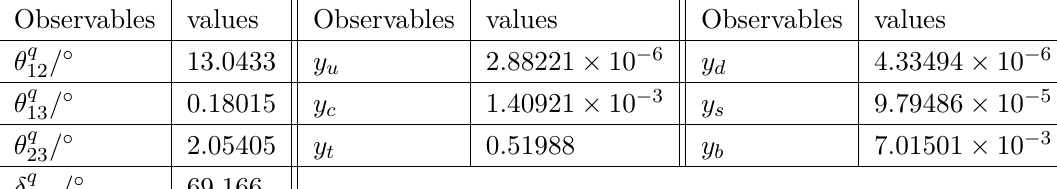
Table 5 . The predictions for the Yukawa eigenvalues, the mixing angles and the CP phase of the quark sector for tan β = 10 .